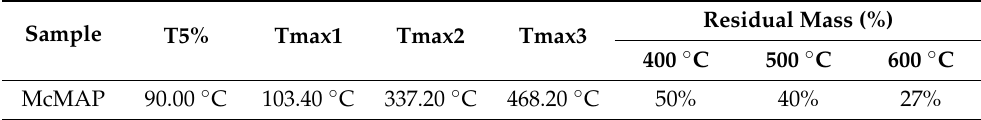
Table 3. Result of decomposition temperature and residual mass of McMAPs microcapsules.